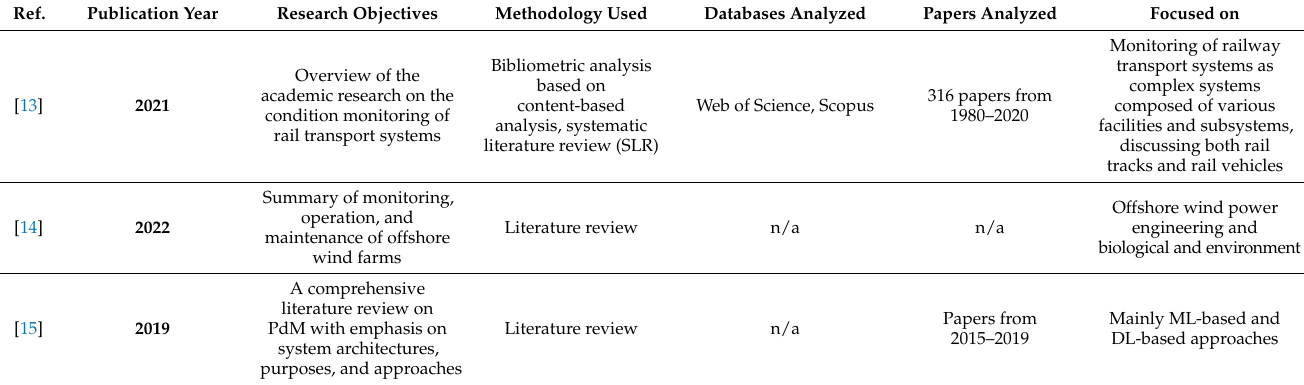
Table 1. A summary of the recent papers focused on the literature overview in the area of Maintenance 4.0.